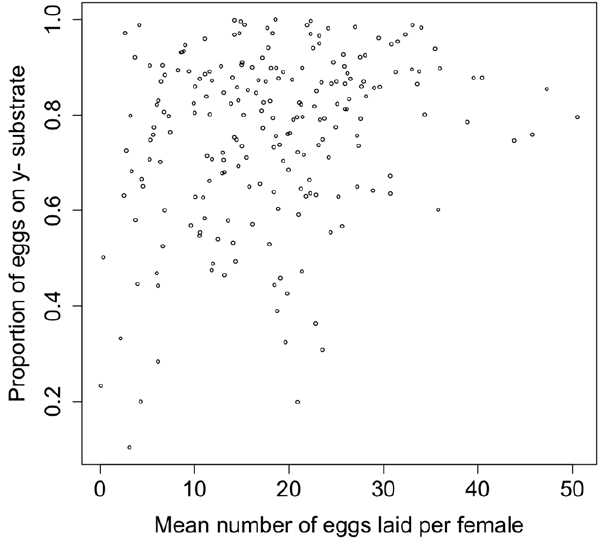
Figure 5. The relationship between average egg number and average preference for each